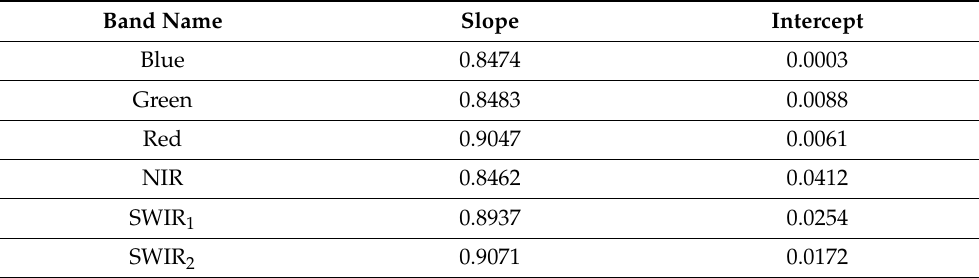
Table 4. Surface reflectance sensor transformation functions (ETM+ to OLI) derived by ordinary least squares (OLS) regression [85].